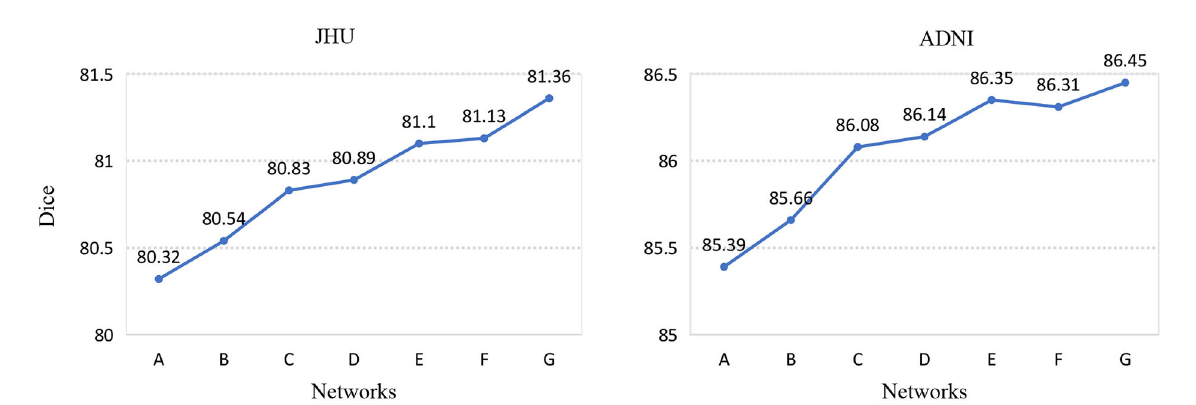
FIGURE5 Seven networks are designed to verify REFM and MCAM. (w/o REFM) denotes that the decoder does not contain the Residual error fusion module. We add different decoders to the same encoder, and each network is represented by a letter, and their detailed correspondence is listed on the bottom side of the figure. Among them, (w/o cross-attention module) denotes that the decoder does not contain the cross-attention module, and ( k = 3, 5) denotes that the size of the convolution kernel of the middle layer of the different branches in the decoder is (3, 3) and (5, 5),